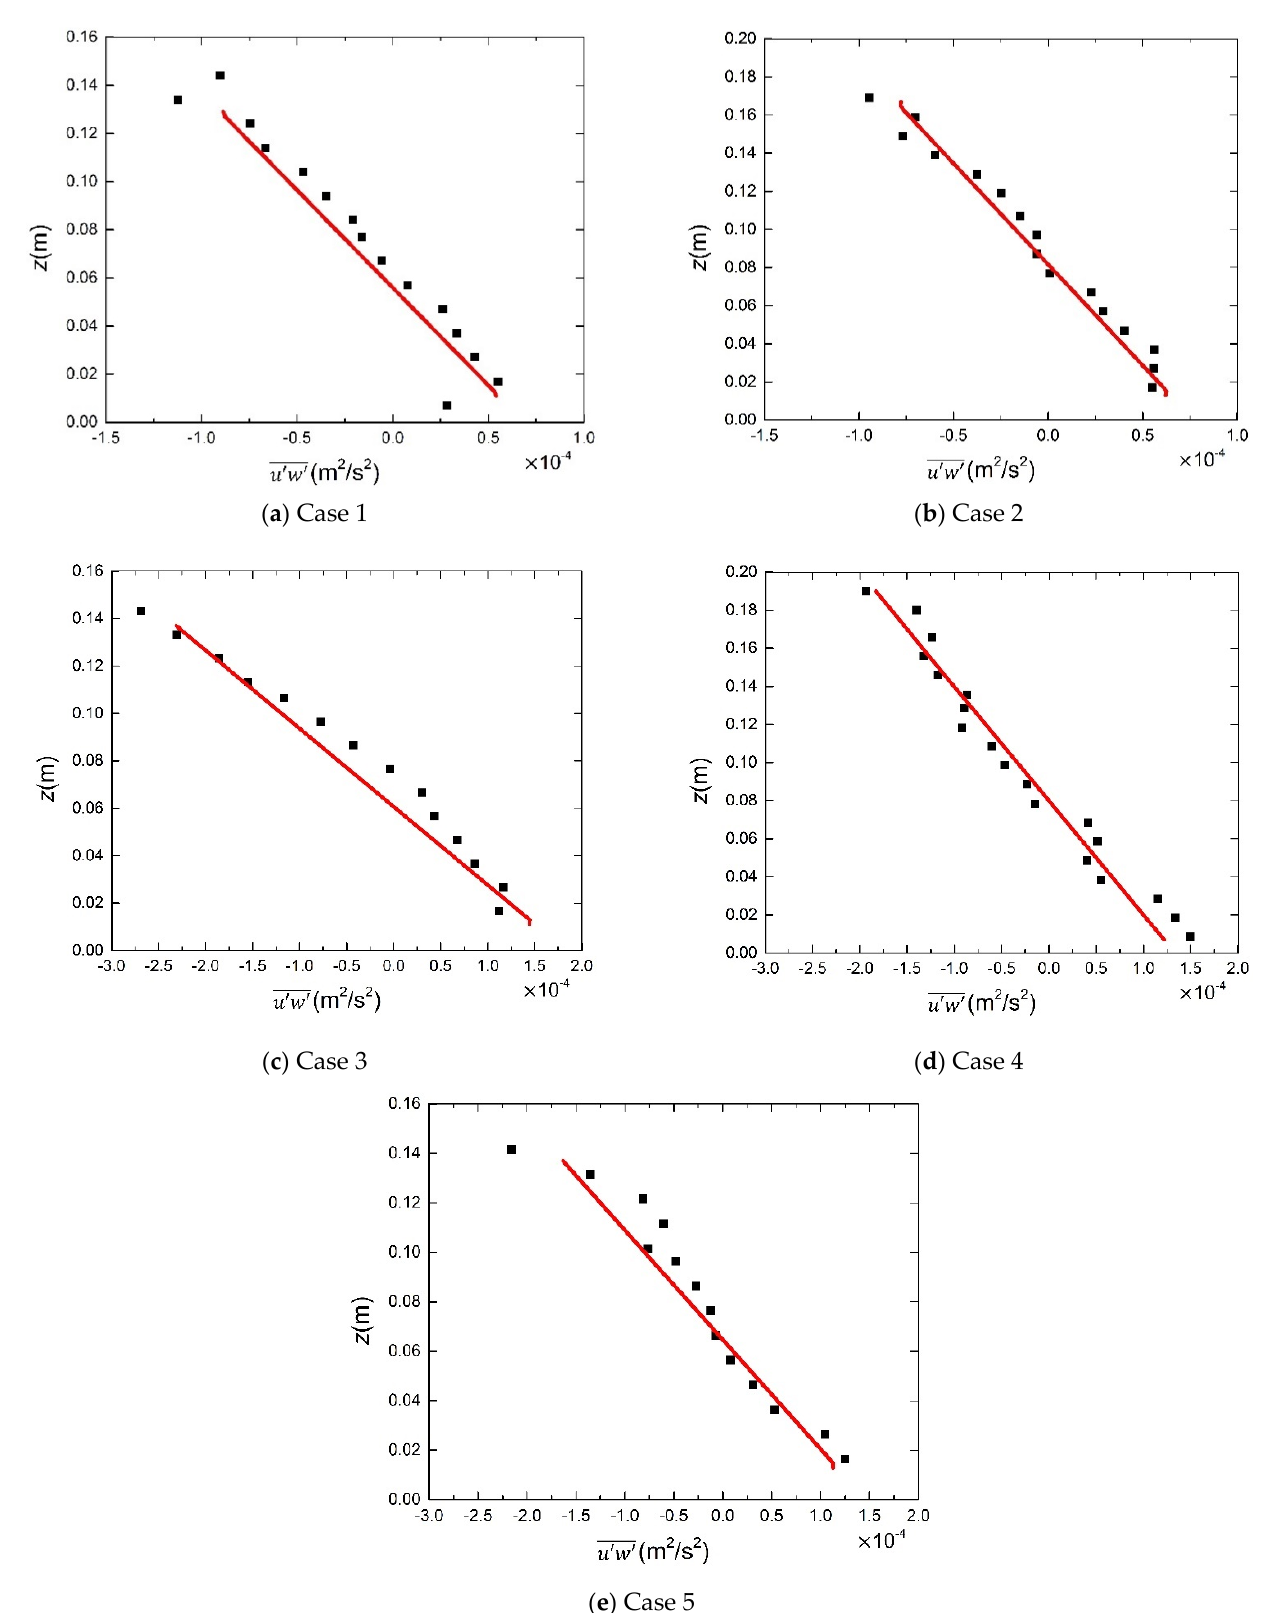
Figure 5. Comparison of the measured and analytical Reynolds stresses. Black squares denote the measured data and red lines denote the analytical ones.